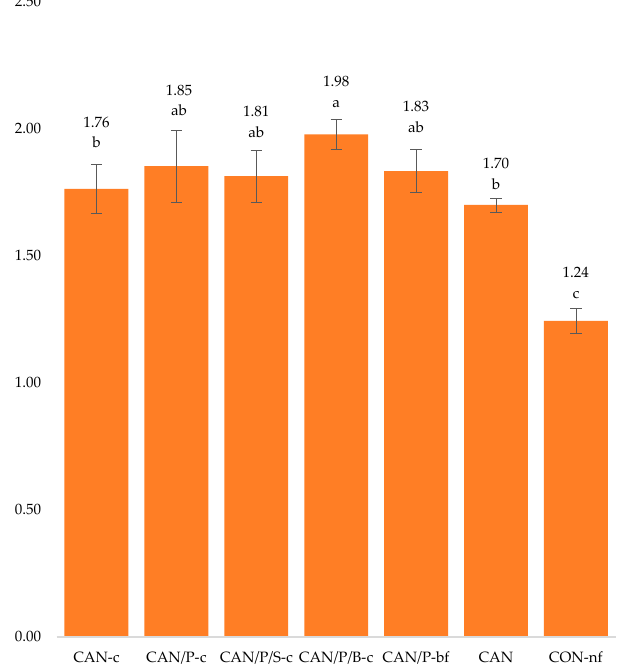
Figure 6. The maize root system size (nF) determined by root electrical capacitance ( C R ). The values of C R are expressed as mean (n = 4); the error bars represent the standard deviation. Different letters above error bars denote statistically significant differences among treatments using Tukey’s post